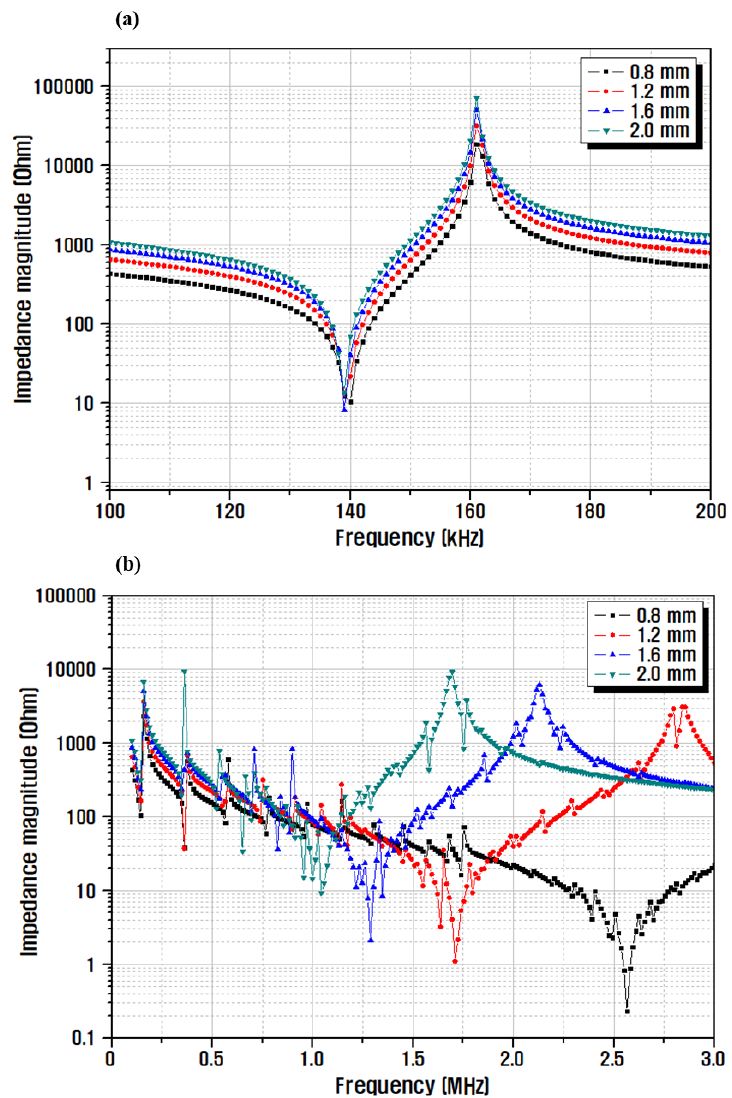
Figure 6. Simulation results of impedance characteristics for different thicknesses of piezoelectric ceramics: ( a ) radial, and ( b ) thickness vibration